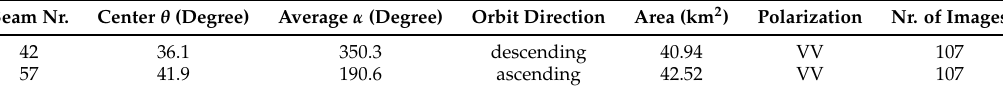
Table 1. Acquisition parameters of stacks of SAR images in Berlin.